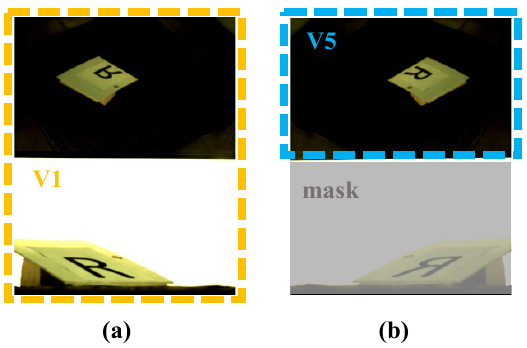
Figure 3. Example of an image taken with Cam 1 (a) with V1 and (b) corresponding flipped image to be used as mirrored camera with V5.